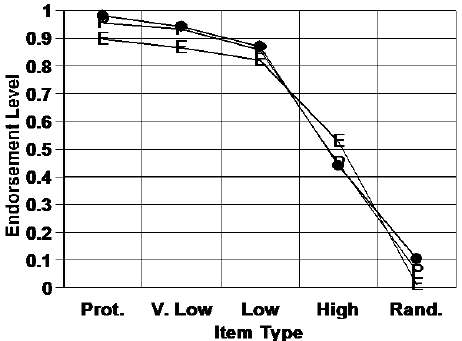
Figure 3. The proportion of times a macaque endorsed into a learned category to-be-categorized items that were outside the category (Rand.), non-typical category members (High-level distortions), typical members (Low-level distortions), highly typical members (V. Low-level distortions), or prototypical members (Prot.). Standard exemplar and prototype categorization models fit the macaque’s performance as well as they could (E symbols and P symbols, respectively). The models differ only in their assumption of multiple, specific-exemplar cognitive reference points for categorization, or a single, central cognitive reference point for categorization. From [18]. Copyright 2008 by the American Psychological Association. Reprinted with permission.